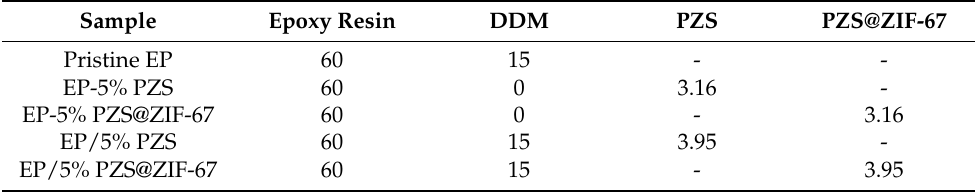
Table 3. The feed ratio of each component in curing DSC